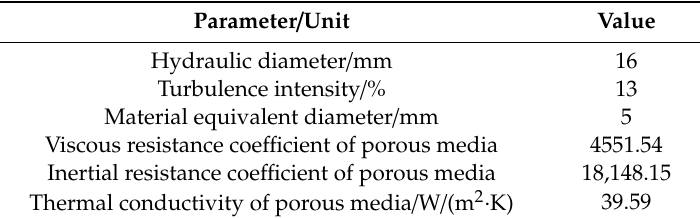
Table 1. Fluent simulation parameter setting.